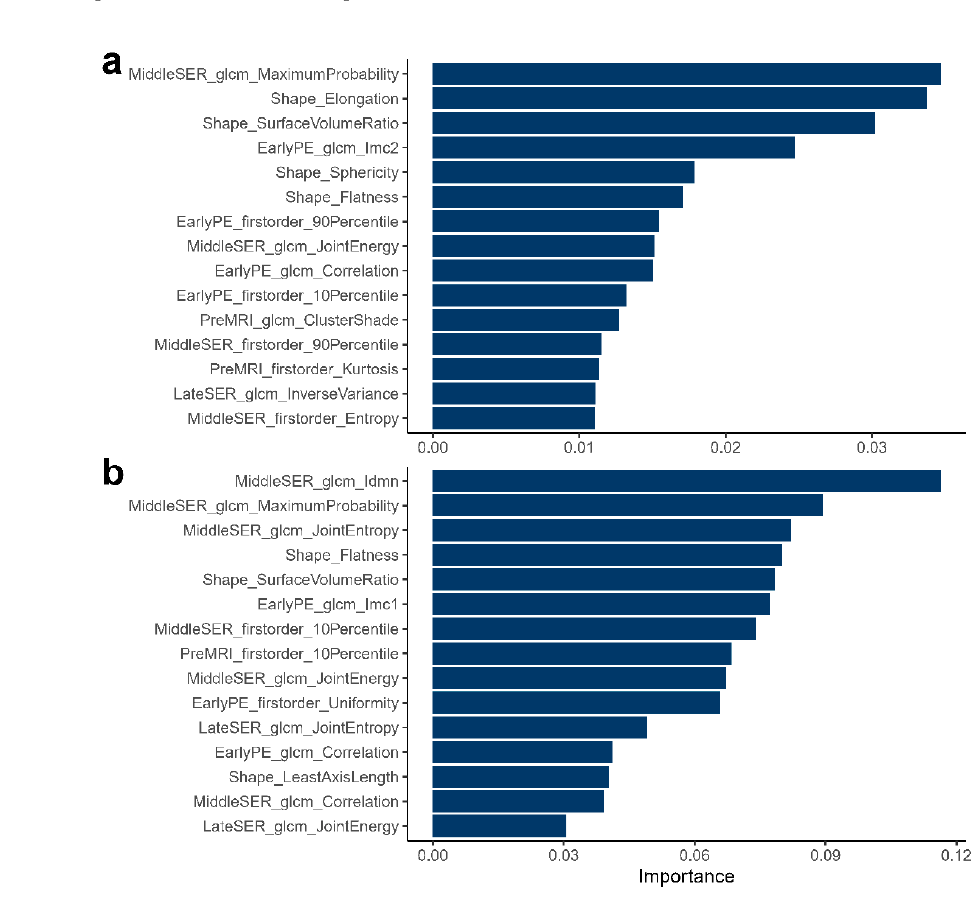
Figure 6. The top 15 important radiomic features for the random forest prediction models of representative hallmark pathways. The top 15 important DCE-MRI features of the G2M checkpoint prediction model and the mTORC1 signaling prediction model are detailed in ( a ) and ( b ), respectively.